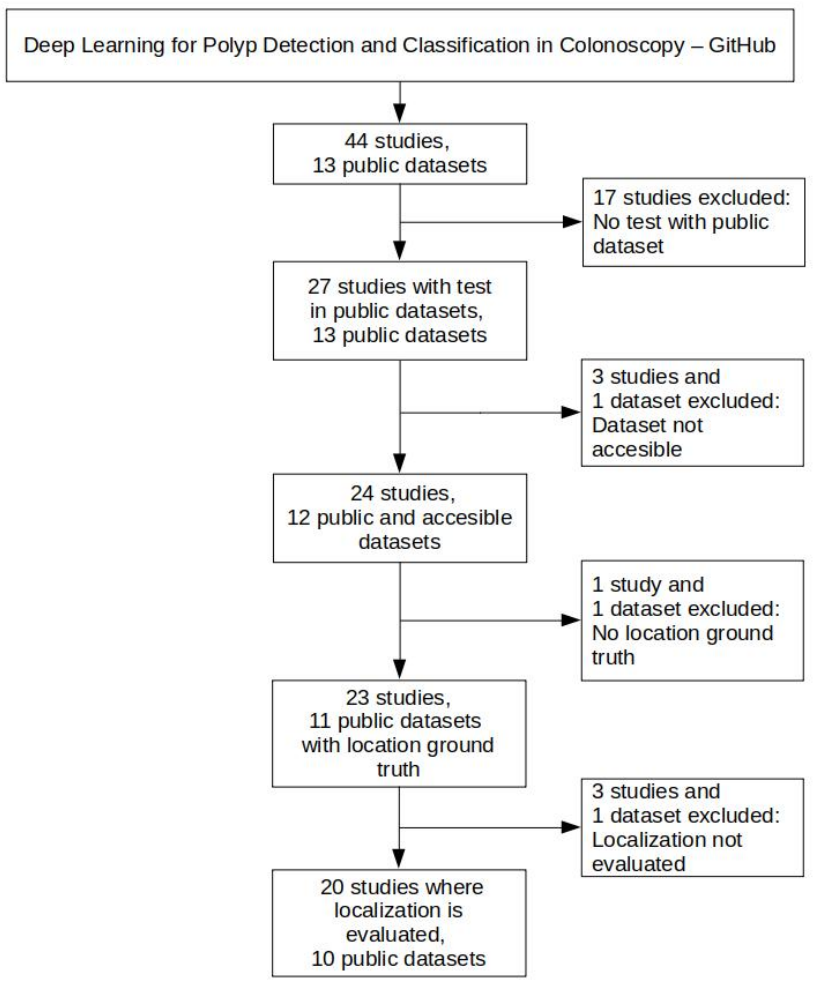
Figure 1. Criteria for selecting polyp localization studies and public colonoscopy image datasets.